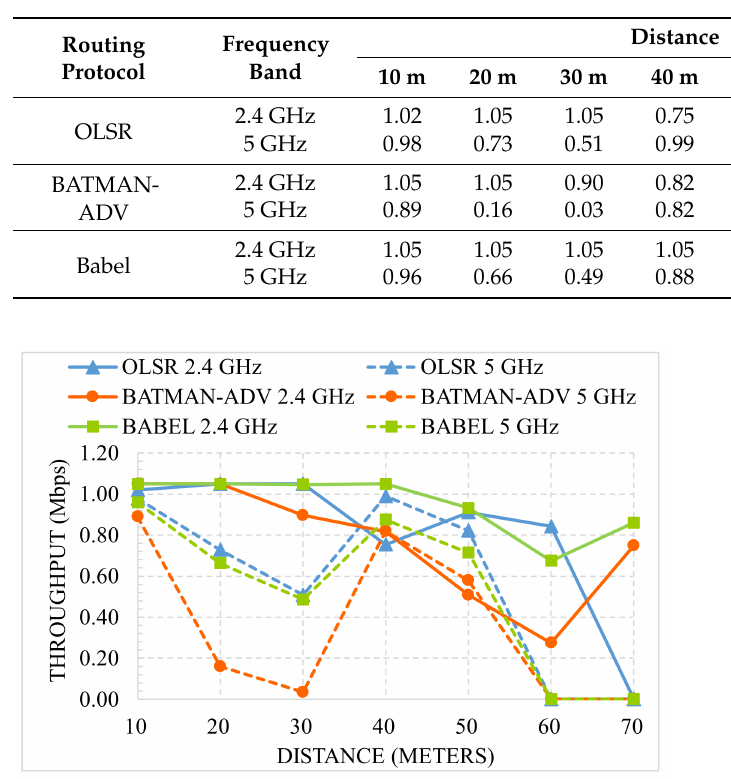
Table 3. Average throughput (Mbps) obtained between PCs-UAVs at different gap distances for OLSR, BATMAN-ADV, and Babel, for 2 frequency bands: 2.4 and 5 GHz. Each measurement had a duration of 60 s.